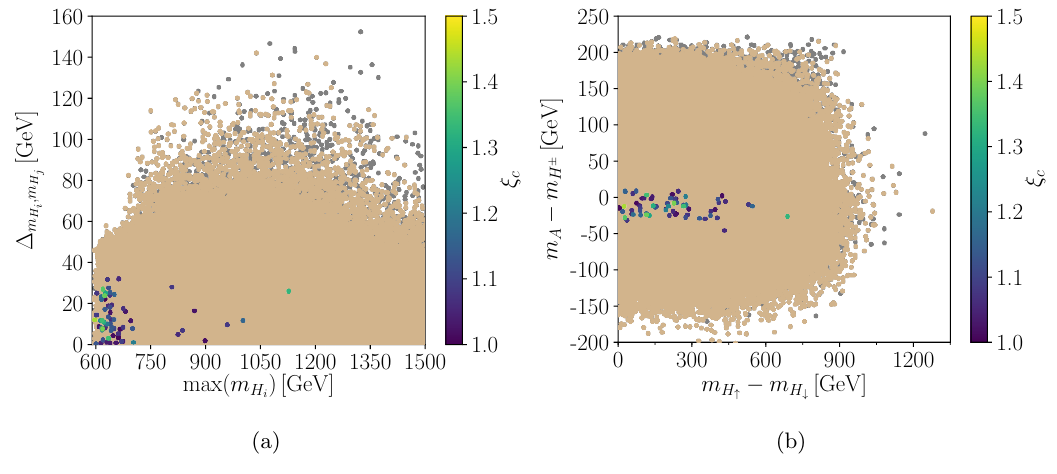
Figure 8 . N2HDM T2: Left: the minimum mass gap (cid:1) m masses. Right: the mass gap between the CP-odd and charged Higgs bosons, A and H (cid:6) , versus the mass gap between the CP-even neutral Higgs bosons H " and H # . The color code is the same as in (cid:12)gure 3. The color bar indicates the strength of the phase transition for (cid:24) c search constraints are